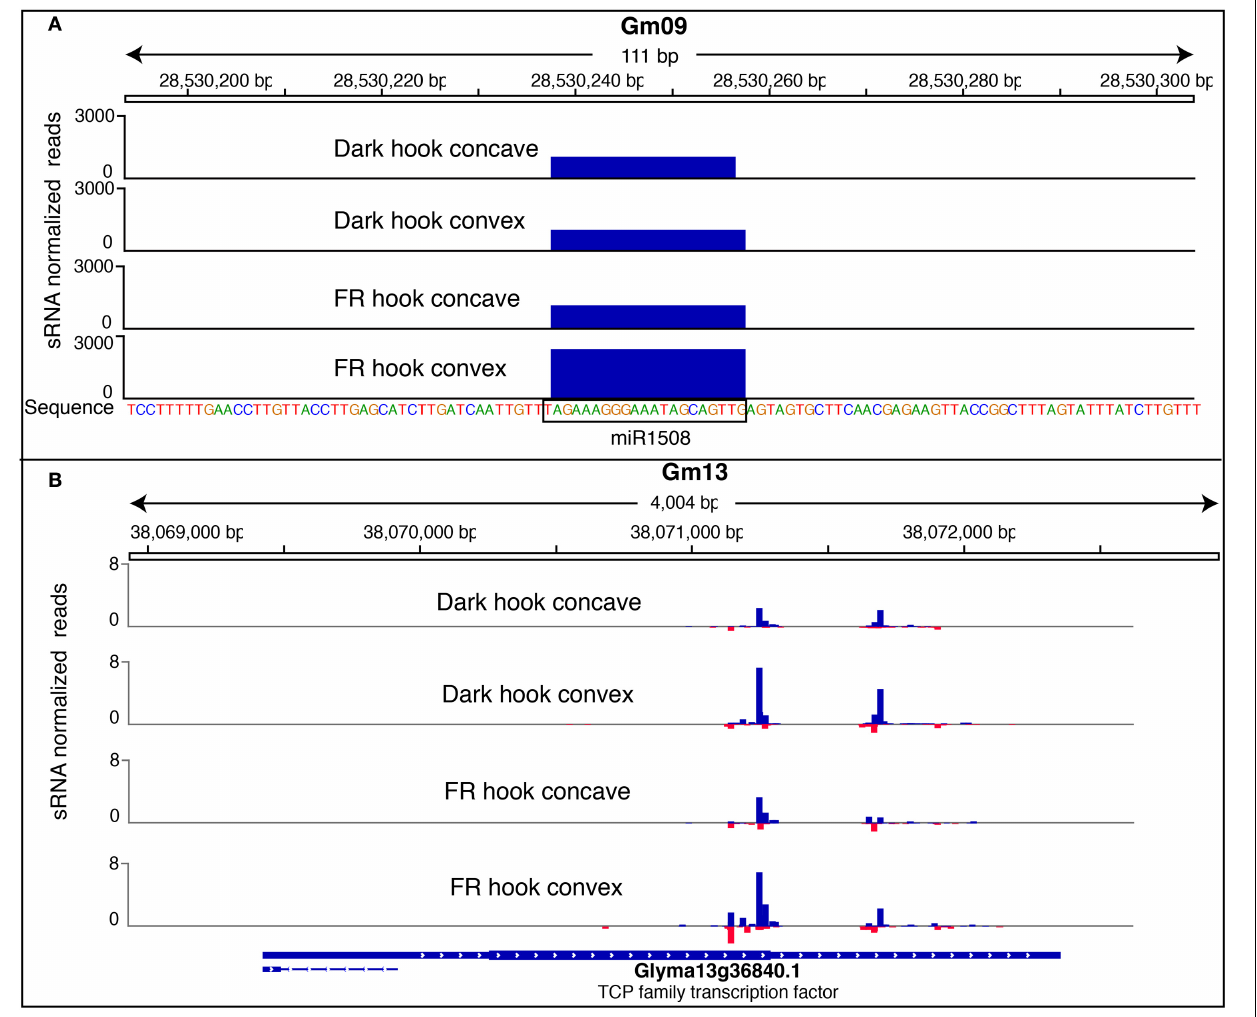
than hook concave co-localizes with a protein-coding gene Glyma13g36840. Eachsamplewasrepresentedasatrack,whiletheY-axisofthetrackrepresents theRPMnormalizedweightedcountsofthesRNAreads(negativevaluemeans mapping to reverse strand). Blue bar represents sRNA mapping to the forward strand, and red bar represents sRNA mapping to the reverse strand. The graph was prepared with Integrative Genomics Viewer (Thorvaldsdóttir et al.,